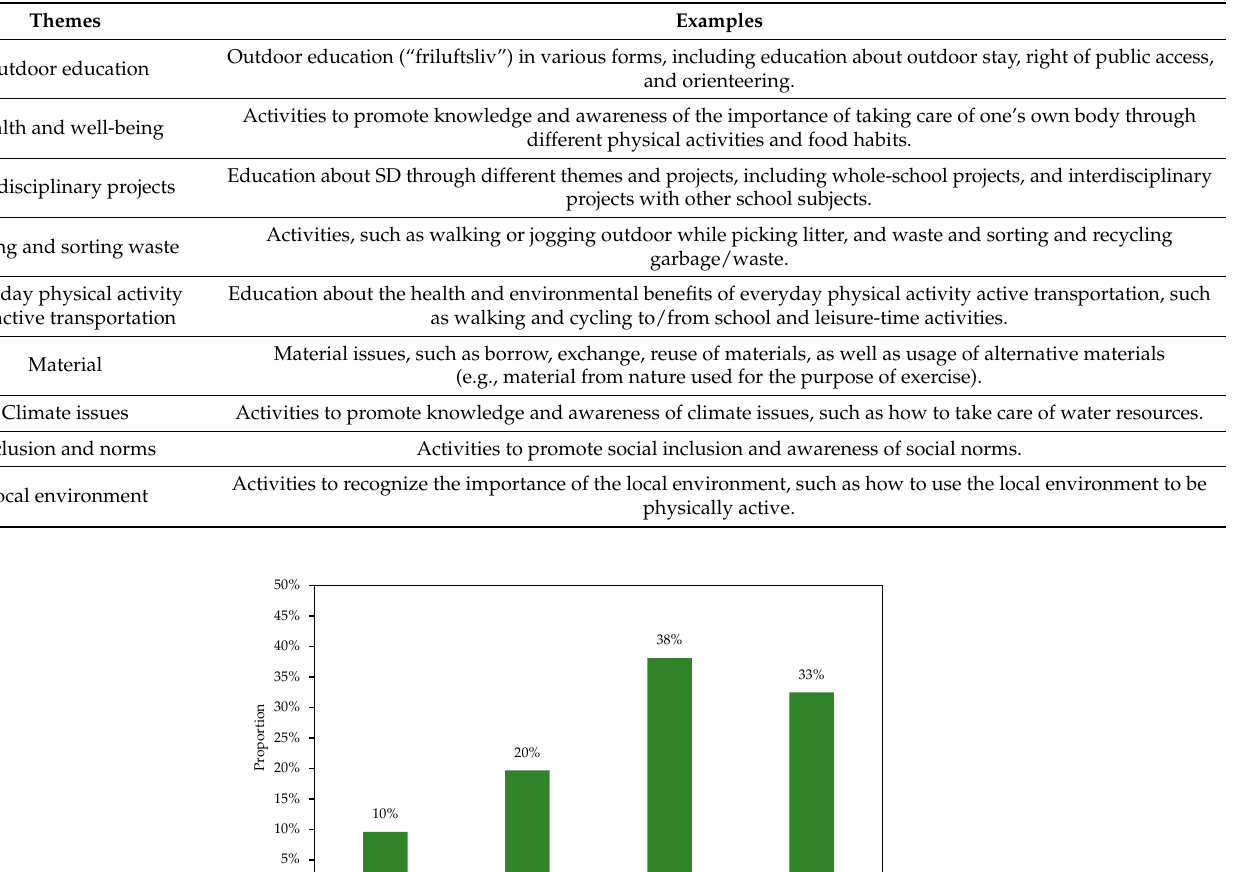
Table 4. The themes that together captured the examples of working areas, activities, or projects related to SD, as stated by the participants.